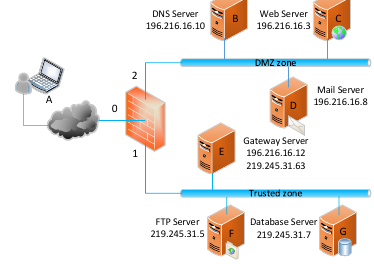
Fig. 2. Experimental Network topology